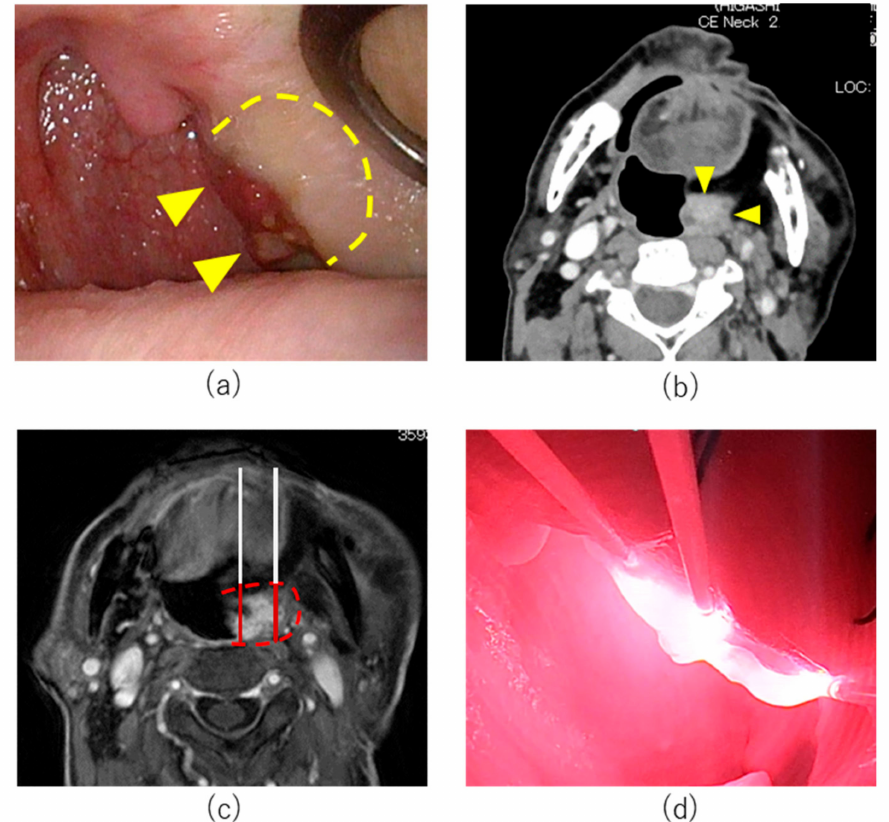
Figure 2. Treatment course of Case 1. ( a ) Pretreatment endoscopic findings: Left oropharyngeal tumor (arrowheads) and tumor induration (dotted line). ( b ) Axial section of Gd-enhanced MRI T1 weighted image. ( c ) Treatment plan of cycle 1 HN-PIT treatment. Planned illumination area (dotted line). ( d ) Intraoperative image of HN-PIT in Cycle 1. Near-infrared laser was illuminated using 20 mm cylindrical